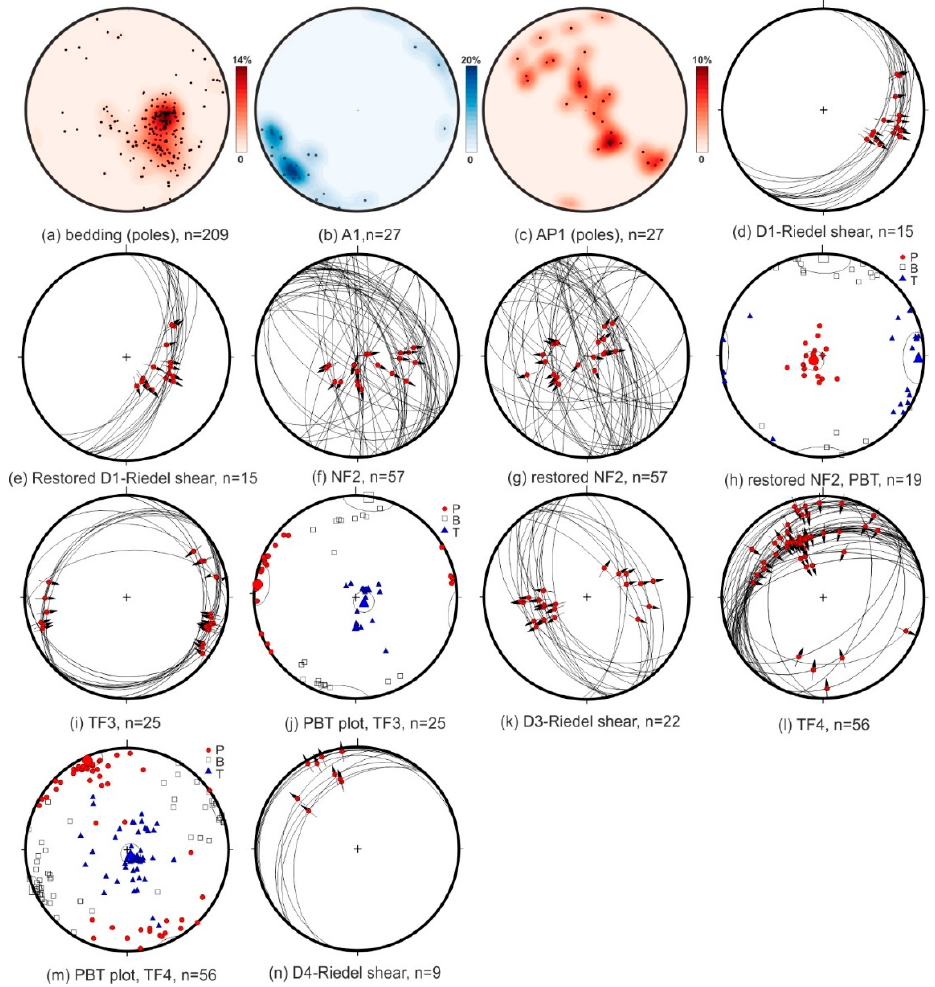
Figure 11. Giffoni tectonic window. ( a – n ) Stereographic projections (lower hemisphere, equiareal net) and PBT plots of the analyzed structures described in the text. A—fold axis; AP—axial plane; NF—normal fault; TF—thrust fault. ( h ) θ = 22°; mean vectors; P: 141/80 (R = 88%); T: 004/10 (R = 78%); B: 273/03 (R = 74%).( j ) θ = 20°; mean vectors; P: 277/03 (R = 82%); T: 007/01 (R = 74%); B: 119/83 (R = 90%).( m ) θ = 38°; mean vectors; P: 155/03 (R = 81%); T: 247/01 (R = 78%); B: 005/87 (R = 84%).